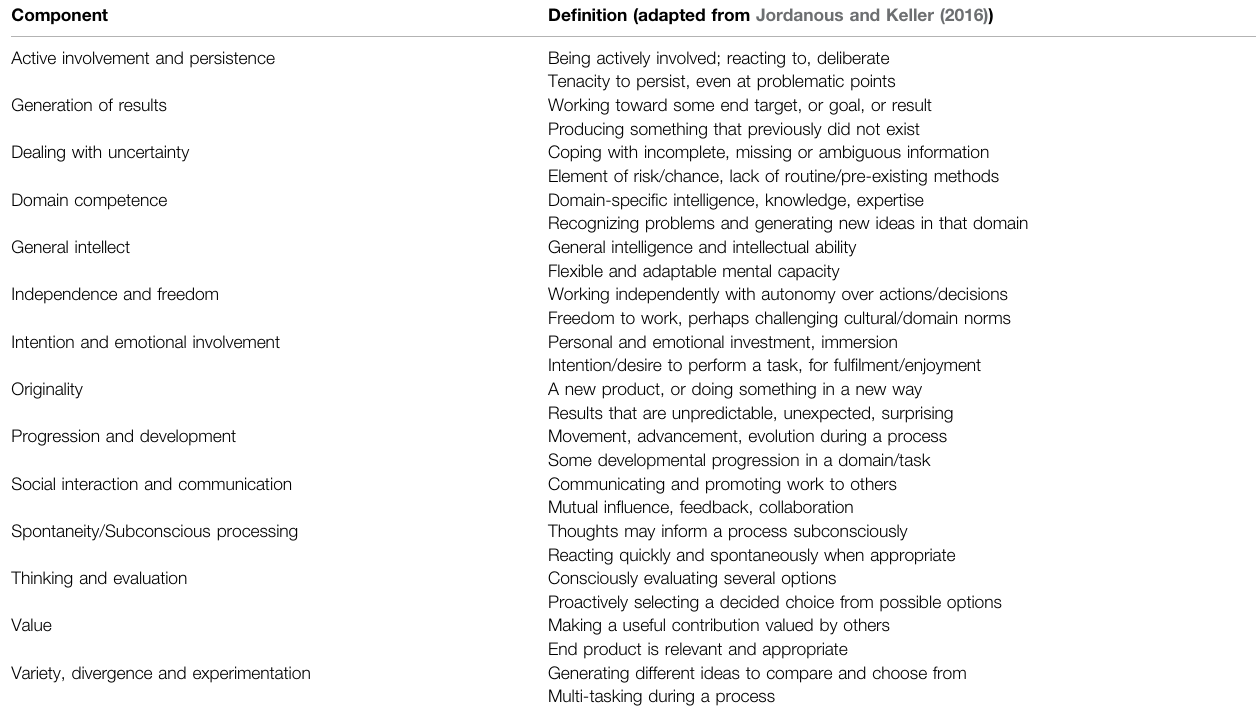
TABLE 2 | Components of Creativity, with de fi nitions adapted from Jordanous and Keller (2016). Component De fi nition (adapted from Jordanous and Keller (2016)) Active involvement and persistence Generation of